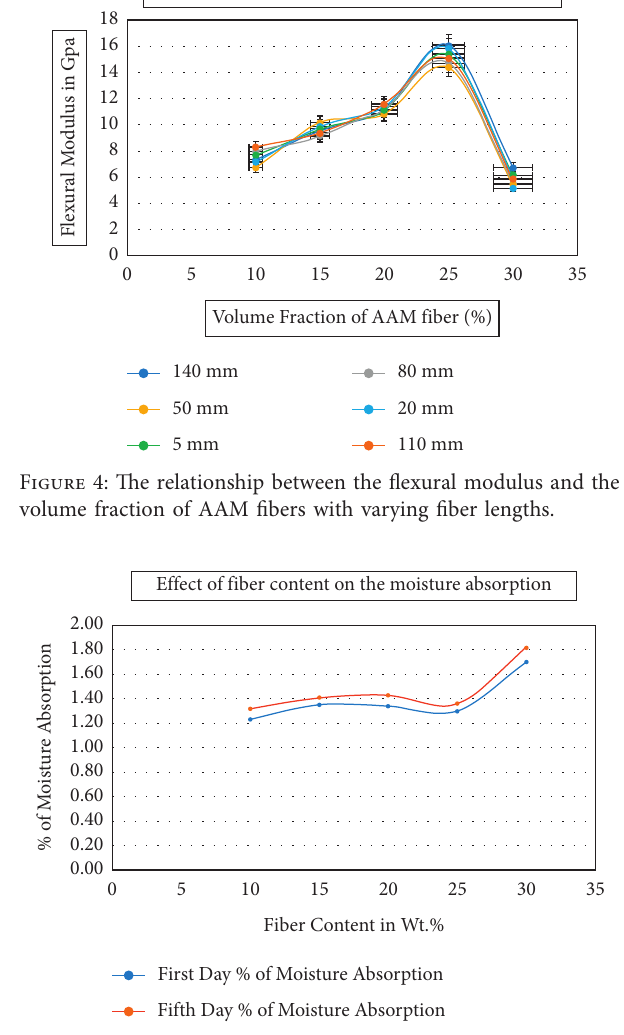
Figure 5: Moisture absorption of 20mm fiber composites with different fiber volumes.